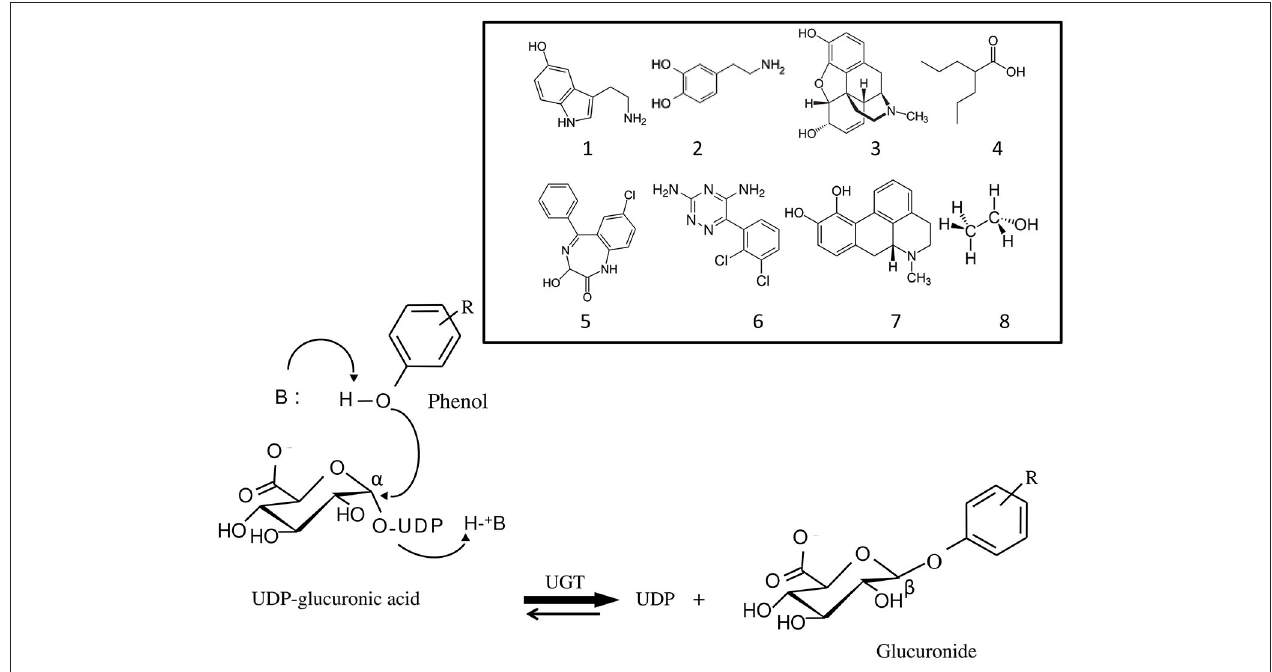
belongs to the inverting glycosyltransferase family which utilizes a direct S N 2-like mechanism involving a base (B) catalyst. Structurally unrelated substances, brain transmitters and drugs against brain disorders that are UGT substrates are shown: 1, serotonin; 2, dopamine; 3, morphine; 4, valproic acid; 5, oxazepam; 6, lamotrigine; 7, apomorphine; 8,